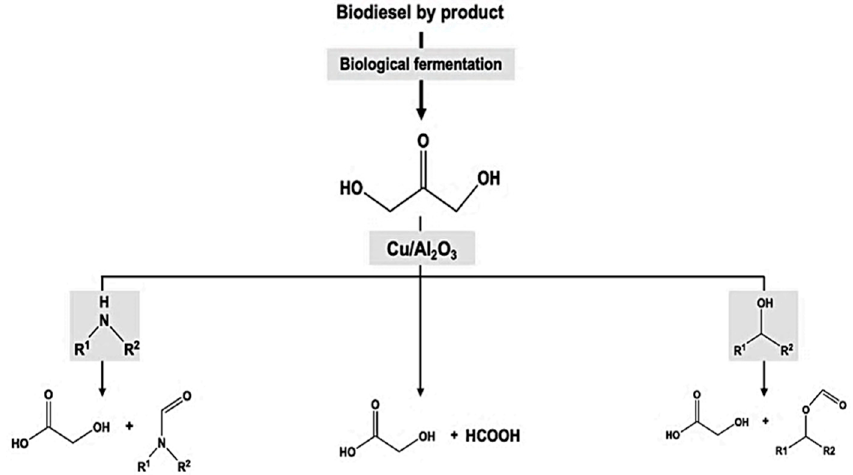
Figure 4. Illustrative diagram of one-pot synthesis method of producing GA, formamides and formates from 1,3-dihydroxyacetone catalyzed by Cu/Al 2 O 3 .